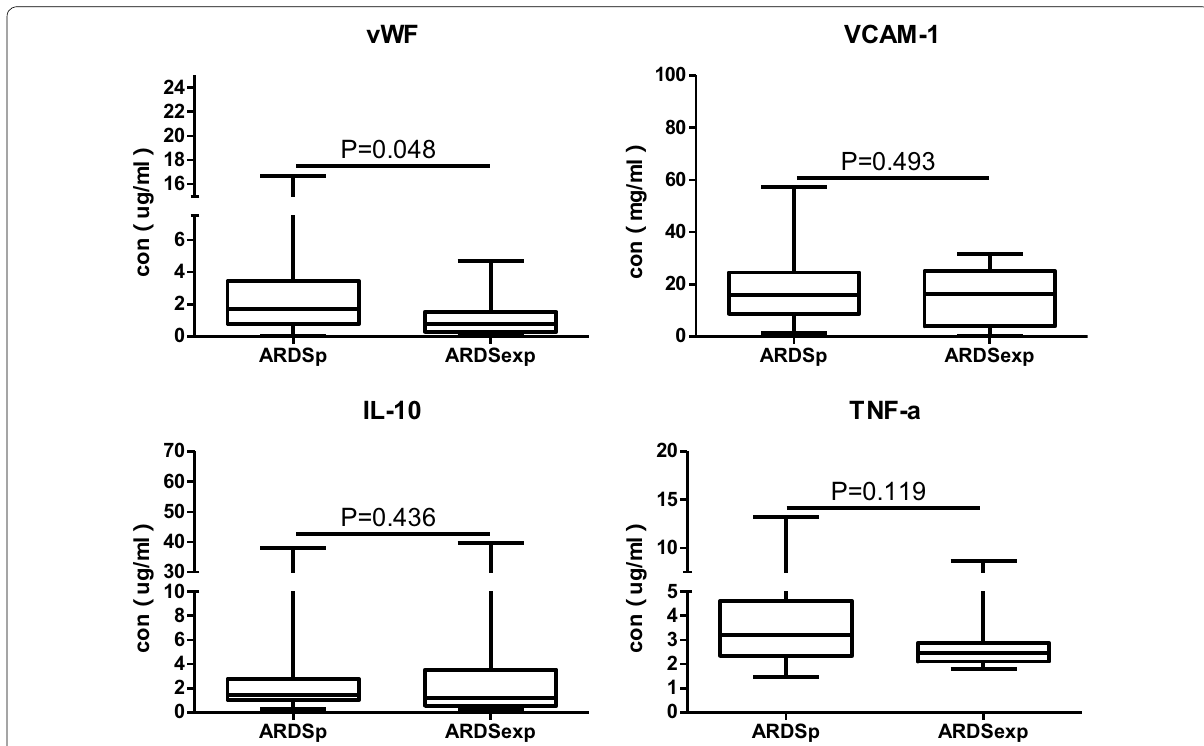
Fig. 2 Comparison of plasma vWF, VCAM‑1, IL10, TNFα concentration between ARDSp and ARDSexp. The concentration unit of vWF, IL10, TNFα is ug/ml. The concentration unit of VCAM‑1 is mg/ml. Box plots are displayed where the horizontal bar represents the median, the box represents the IQR and the whiskers represent the maximum and minimum values. Comparisons made by Mann–Whitney U test